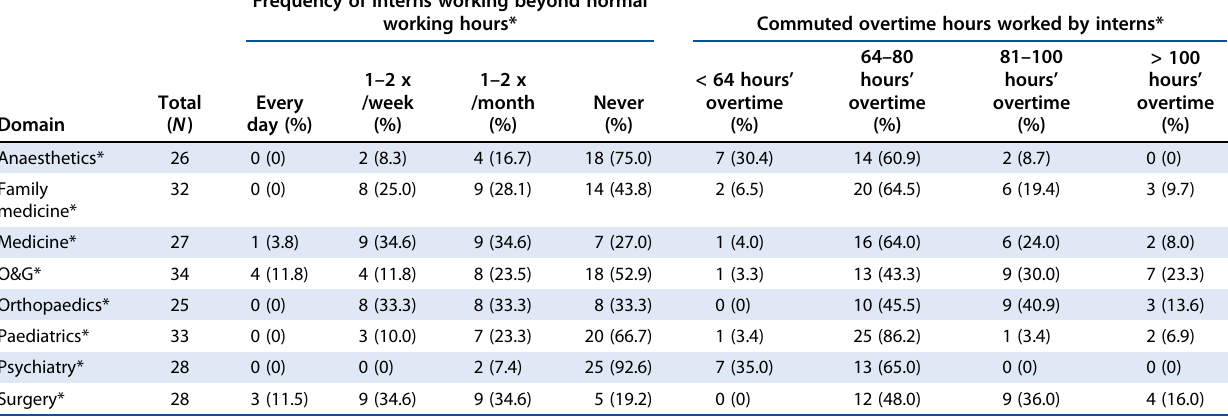
Table 3: Frequency of interns working outside contracted working hours (e.g. outside 8 am – 4 pm) as well as amount of commuted overtime worked in each domain